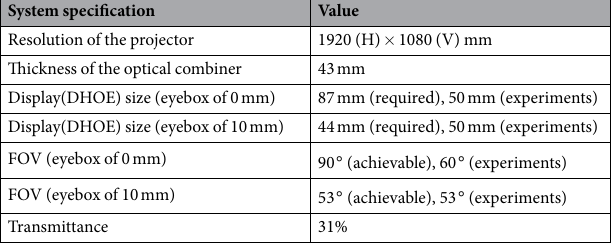
Table 2. Specification of proposed AR-HMD system using